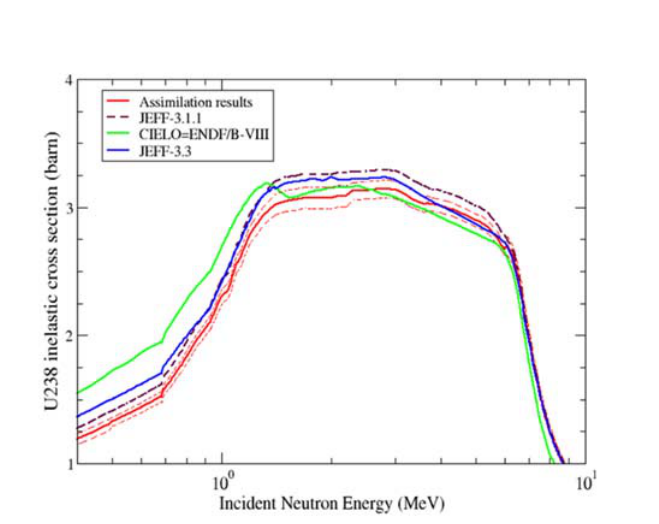
Figure 3 : Assimilation Results compared to major evaluations for 238 U